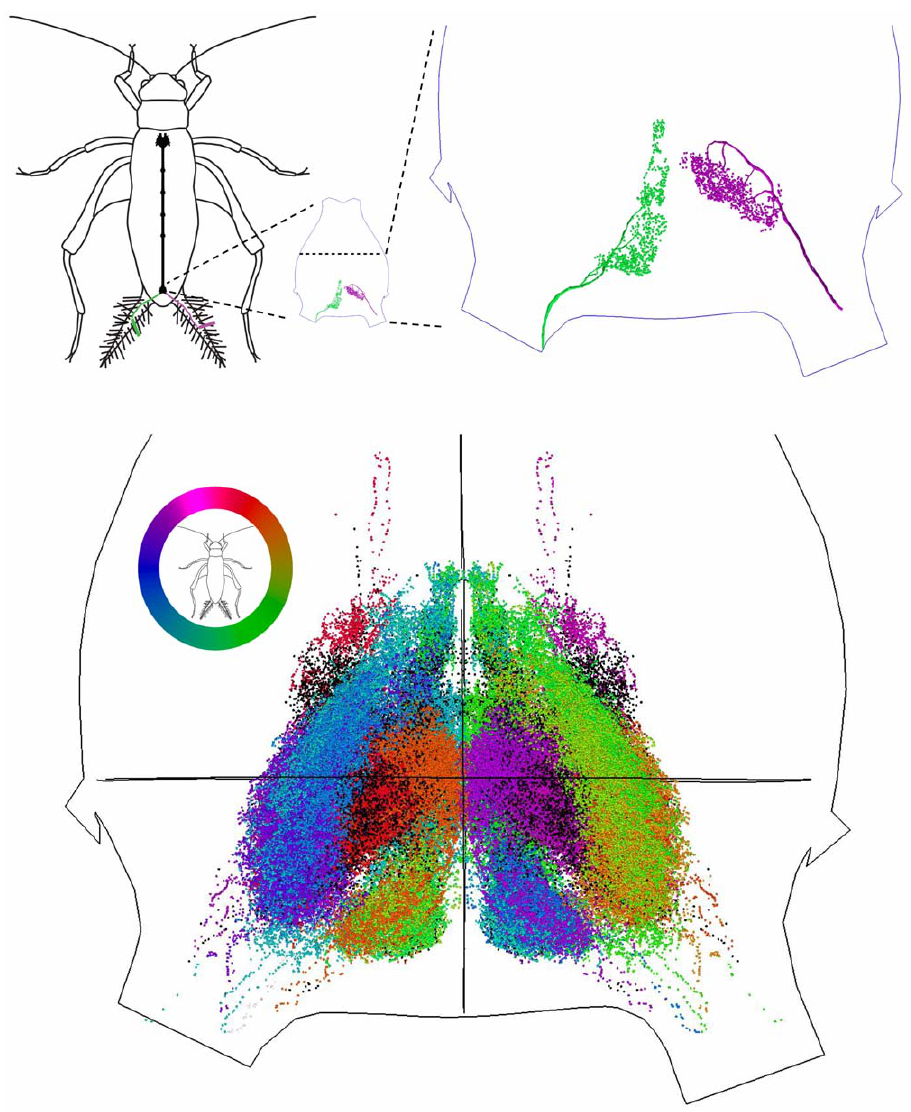
Figure 2. The afferent terminals locus of AchetaDomestica . (Upper left) Axons of afferent neurons, which are attached to filiform hairs, project into the terminal ganglion. (Upper middle and upper right) Each axon branches into a tree-like structure in which individual branches are covered by synaptic boutons that provide connections with interneurons in the terminal ganglion. (Bottom) The entire collection of synaptic boutons over all experimentally examined filiform hairs. The color wheel represents the preferred direction of motion of a hair, which correspondingly represents the preferred response direction of the afferent neurons. (Data generously shared by G. Jacobs and collaborators).